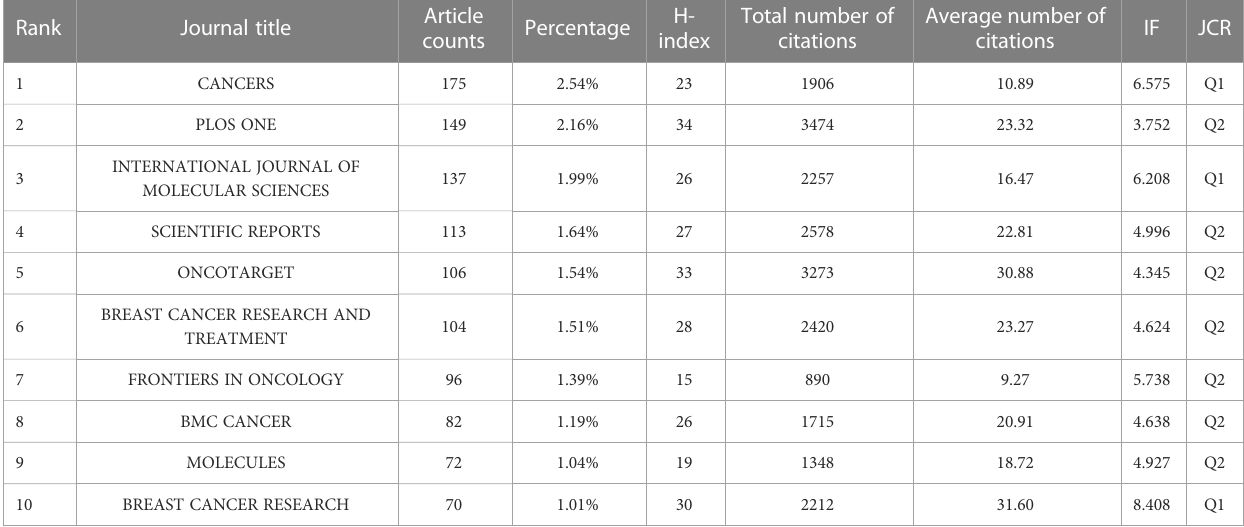
TABLE 5 The top 10 most active journals that published articles about in fl ammation in breast cancer.